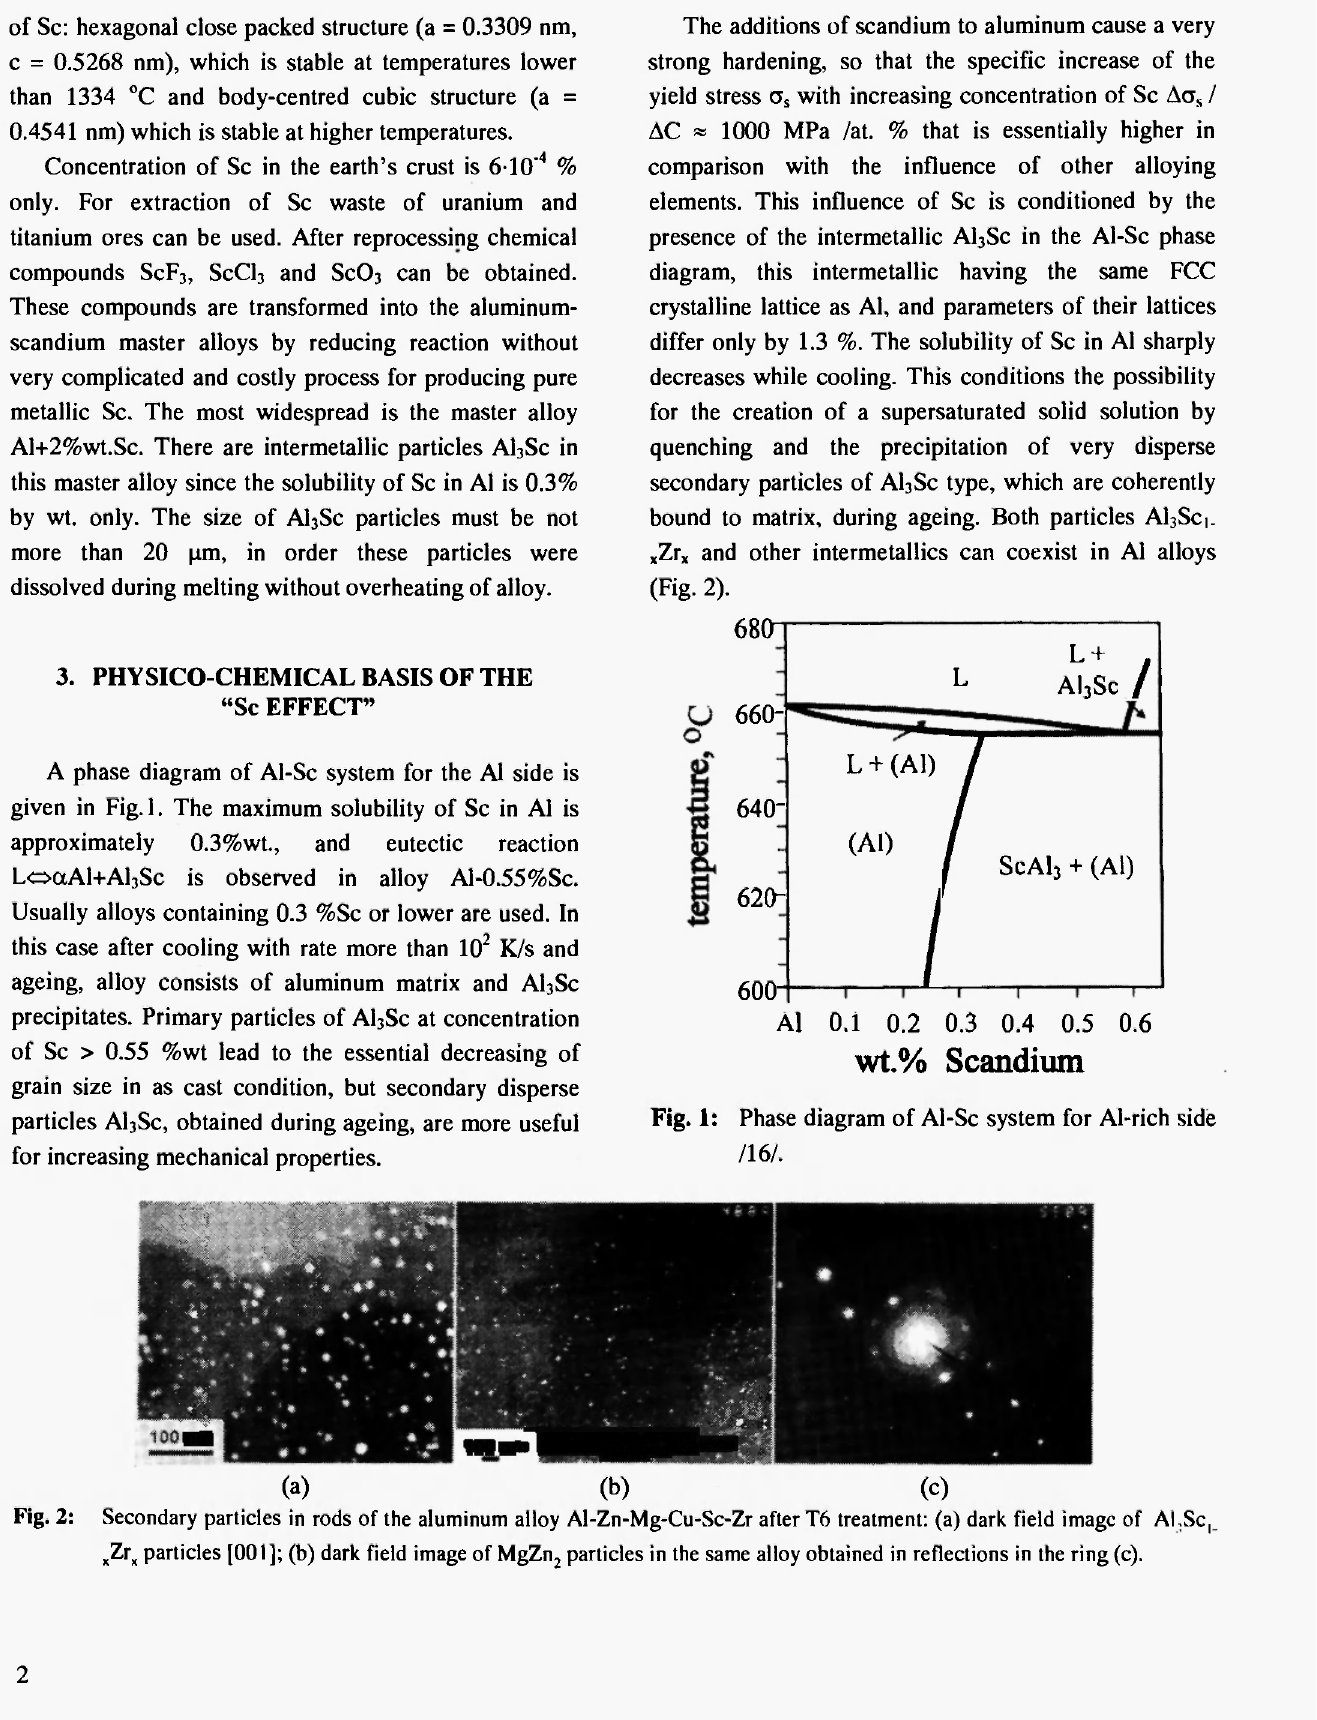
Fig. 1: Phase diagram of Al-Sc system for Al-rich side /16/.